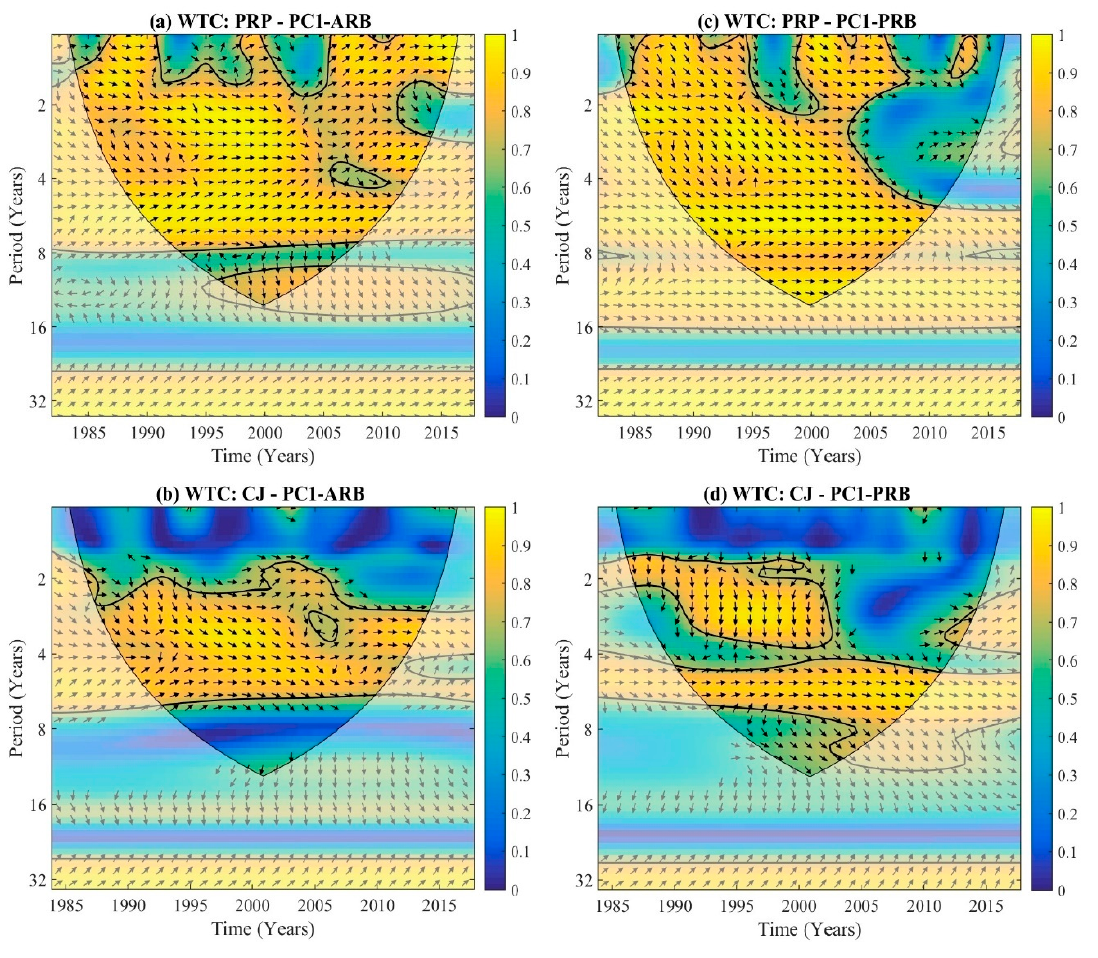
Figure 10. Wavelet coherence and phase differences between the PC1 series at ARB and ( a ) (PRP) and ( b ) Choco low-level jet (CJ). Additionally, PC1 series at PRB and ( c ) PRP and ( d ) CJ. As in Figure 8.